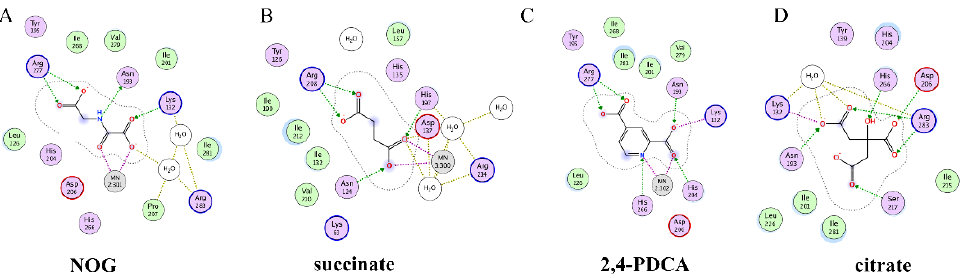
Figure 8. Two-dimensional representation of ligand–protein interactions of ALKBH5 inhibitors with ALKBH5 protein using MOE software. ( A – D ) Crystal structures of ALKBH5 with different com- pounds: ( A ) NOG (PDB ID: 4NRP); ( B ) succinate (PDB ID: 4NPM); ( C ) 2,4-PDCA (PDB ID: 4NRQ); ( D ) citrate (PDB ID: 4O61).